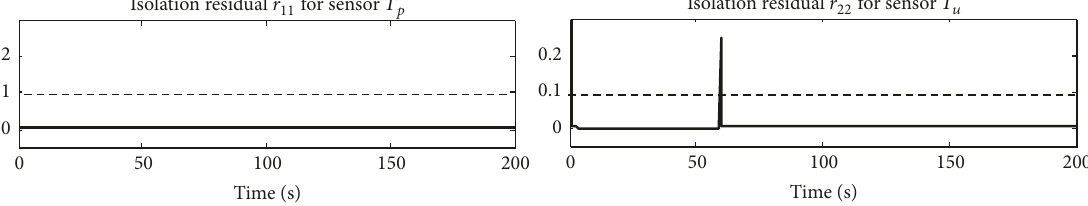
Figure 14: Isolation residuals for sensor fault.